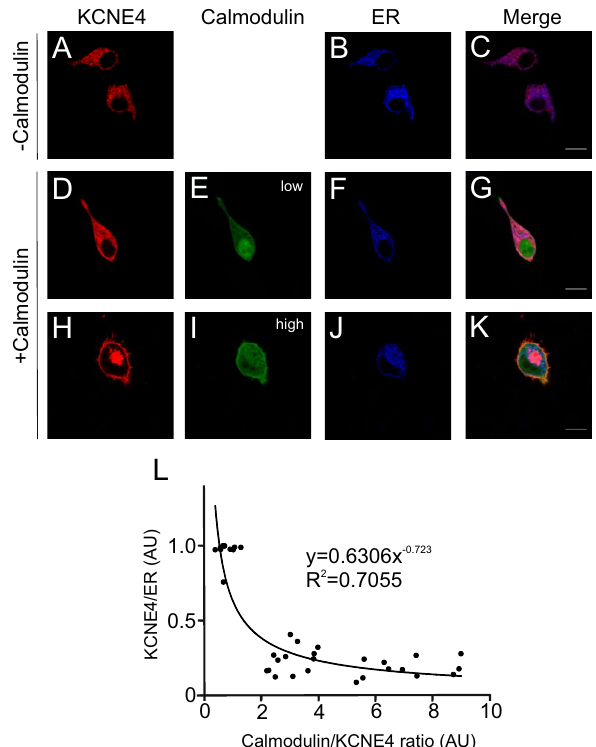
Figure 7. Endoplasmic reticulum colocalization of KCNE4 in the presence of CaM. HEK-293 cells were cotransfected with KCNE4-CFP, CaM-YFP and pDsRed-ER. ( A–C ) Colocalization of KCNE4 to the ER in the absence of CaM. ( D–K ) Colocalization of KCNE4 to the ER in the presence of CaM. ( D – G ) Representative images of a cell expressing low levels of CaM. ( H–K ) Representative images of a cell expressing high levels of CaM. ( A , D , H ) KCNE4-CFP, red; ( E , I ) CaM-YFP in green; ( B , F , J ) ER, blue; ( C , G , K ) merged panels. Purple indicates colocalization of KCNE4 and ER markers. Yellow, colocalization of KCNE4 and CaM. White and light pink indicate triple colocalization. Scale bars represented 10 µm. ( L ) ER colocalization of KCNE4 plotted against the CaM/KCNE4 ratio. All images were captured with the same laser intensity and photomultiplication parameters. A pixel-by-pixel analysis was performed to determine the relative KCNE4/ER and the CaM/KCNE4 ratios. The regression curve and a high R 2 value are indicated. Values were from 20–30 cells. Note: High levels of CaM correspond to low ER colocalization of